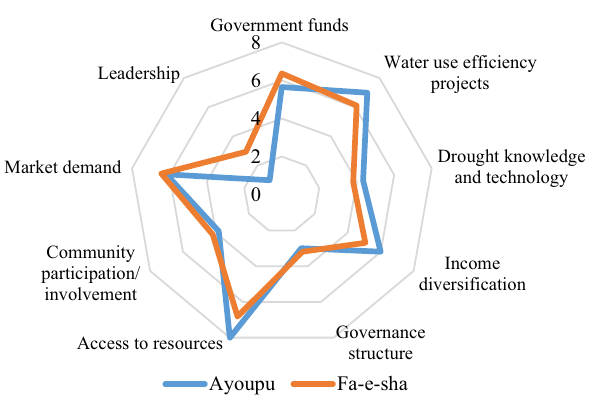
Fig. 4 Administrative village-wise perception on effectiveness of policy to deal with drought (10-highly effective, 1-not effective) in the study villages of Yunnan Province, China. Source Focus group